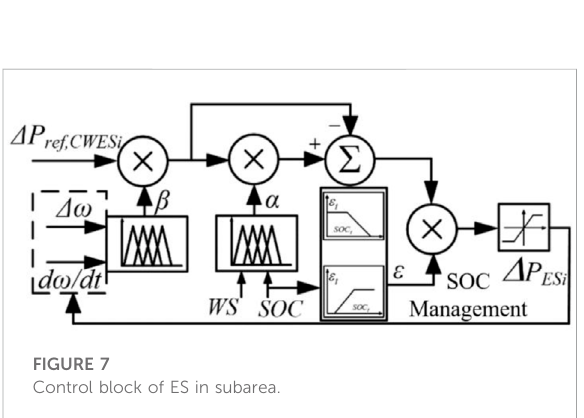
FIGURE 7 Control block of ES in